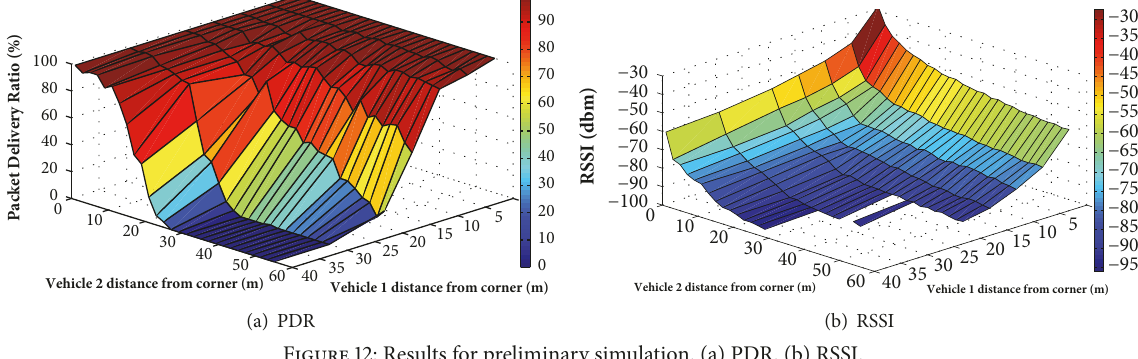
Figure 12: Results for preliminary simulation. (a) PDR. (b) RSSI.